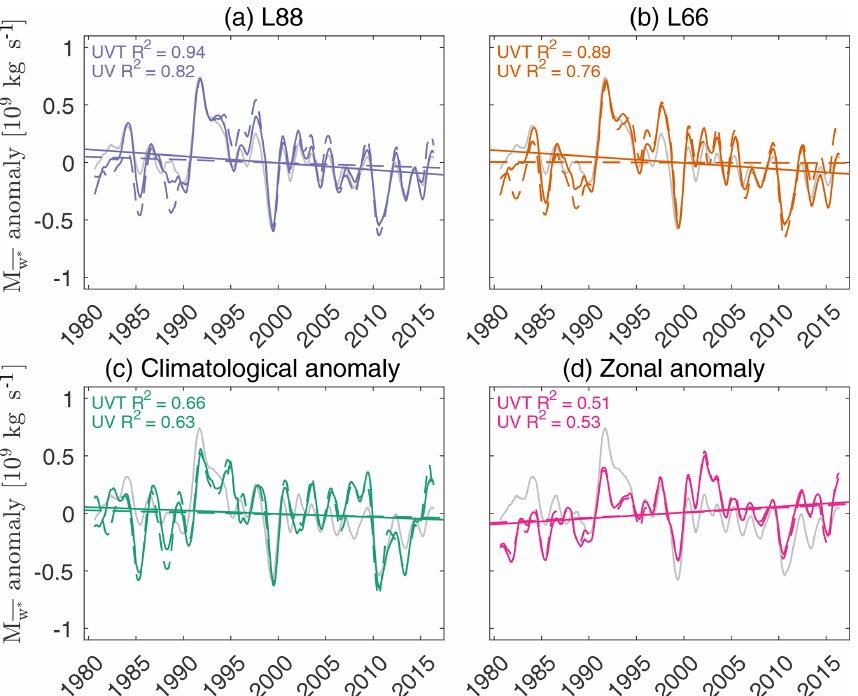
Figure 5. Twelve-month low-pass-filtered time series of tropical upwelling mass flux and its linear trend at 85hPa in the (a) standard L88 nudging, (b) standard nudging, (c) climatological anomaly nudging, and (d) zonal anomaly nudging simulations, with UVT and UV nudging indicated by the solid and dashed lines and MERRA2 indicated by the solid grey line. The correlation coefficient squared between each time series and MERRA2 is shown in each panel.